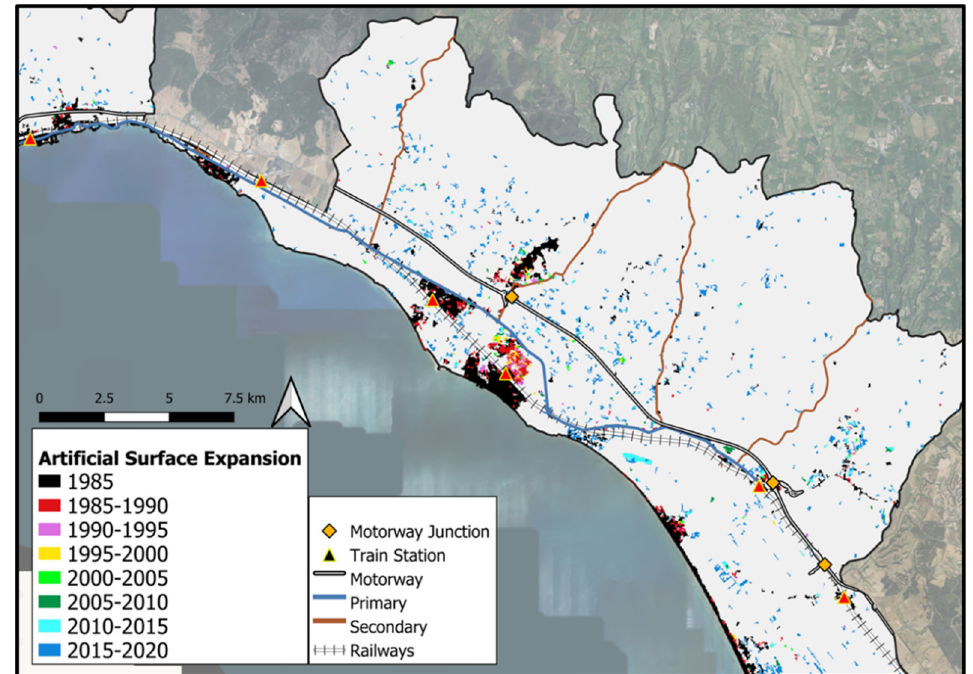
Figure 13. Artificial surface evolution in the municipalities of Cerveteri and Ladispoli through the years. Image sieved at a threshold of 10 pixels, 8-bit connectivity.